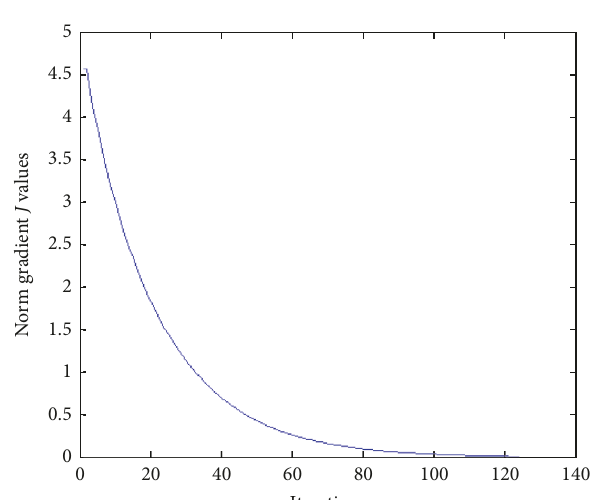
Figure 7: Initial temperature in err = 10% ‖𝜓 exact 0 ‖ 2 case. The recon- Figure 4: Norm of gradient of 𝐽 . structed initial condition begins to move away from the true